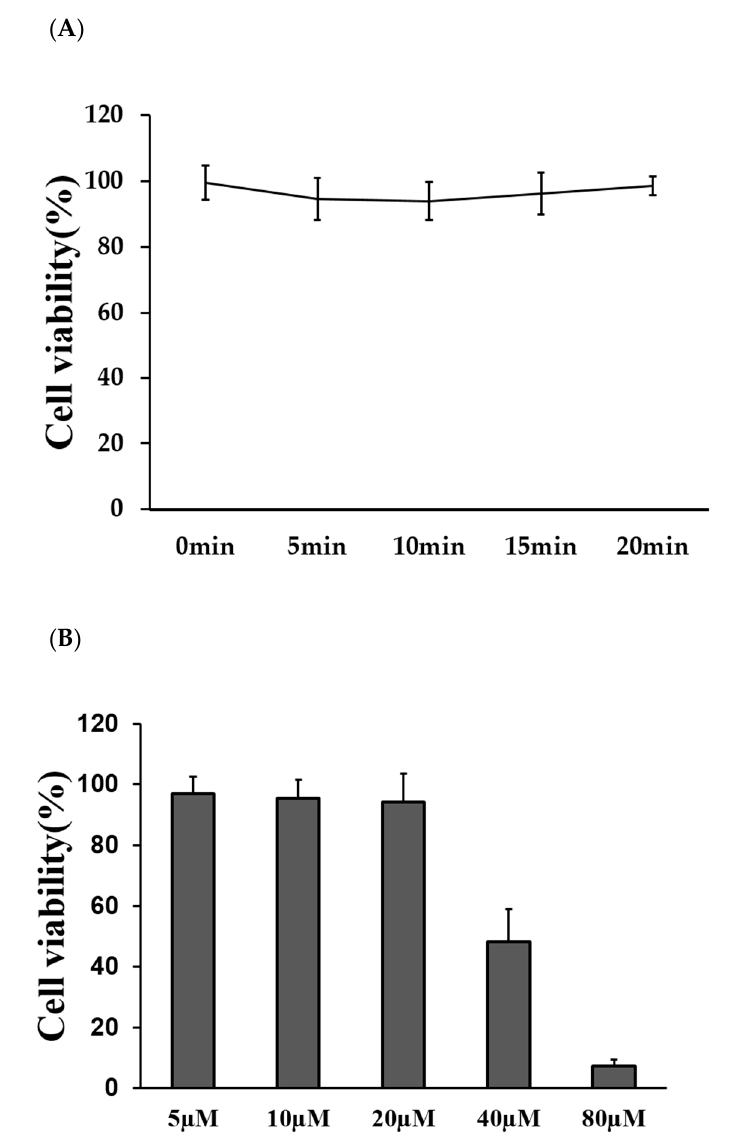
Figure 3. Results of cell cytotoxicity in each group using LDH assay. ( A ) Blue-light-induced cytotoxicity in ARPE-19 cells without A2E, ( B ) the toxicity of A2E in the dark was examined. Cell death was quantified by LDH assay; absorbance value was normalized to untreated control samples (only A2E-loaded ARPE-19 cells). Values are mean ± SEM of three independent experiments performed at different times.